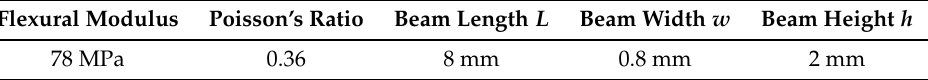
Table 2. Material and geometry parameters of honeycomb metastructures. Flexural Modulus